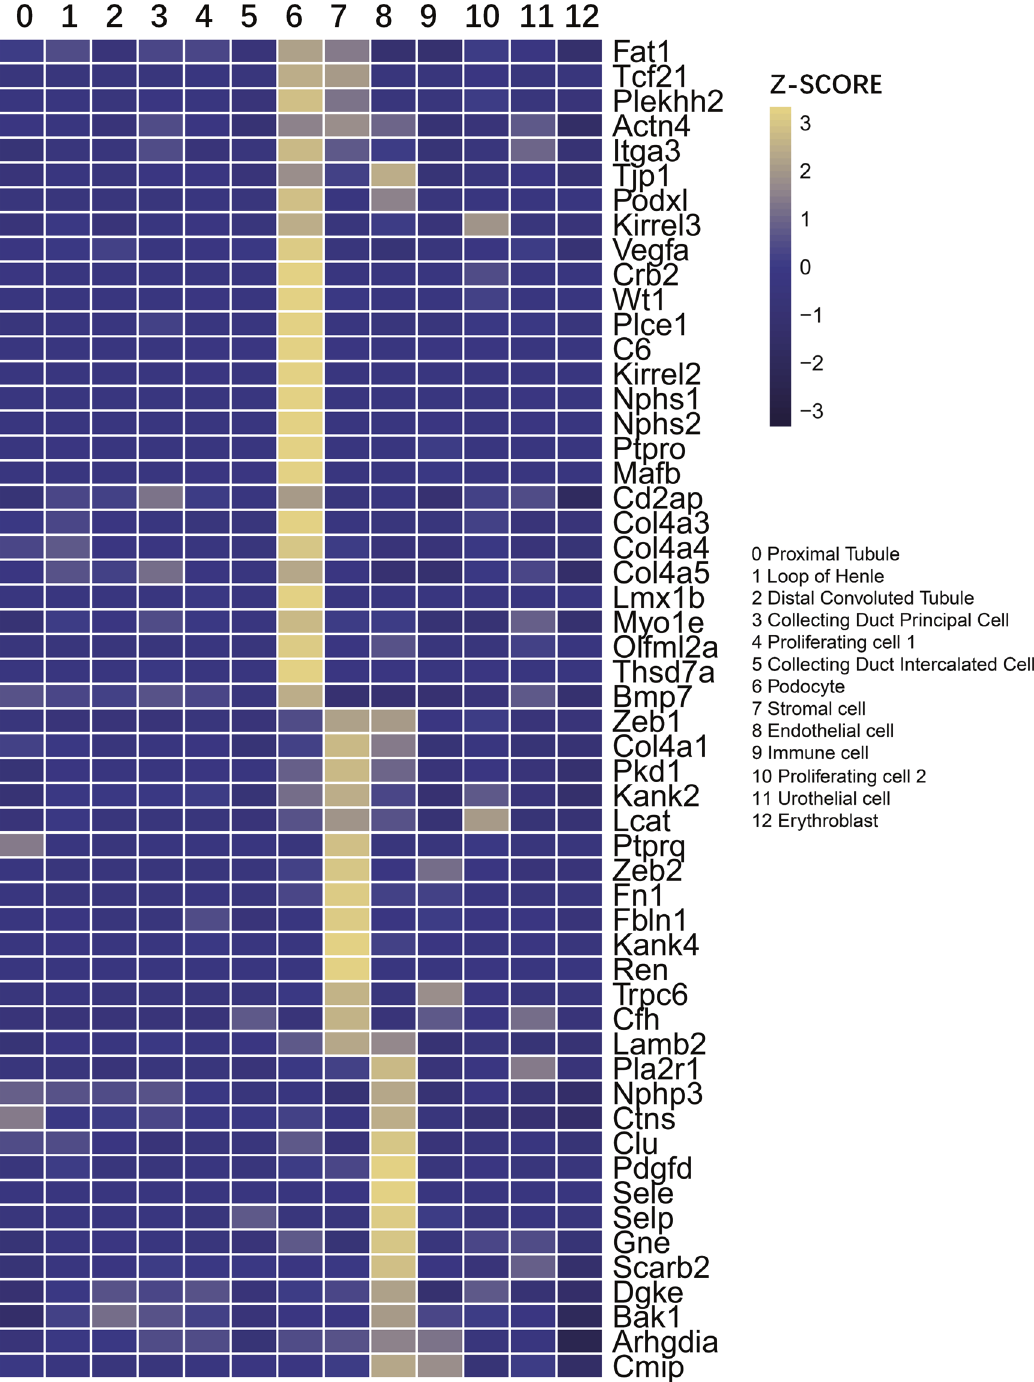
Fig. 5 Expression features of known glomerular diseases genes. Clustered expression of known glomerular disease genes collected from OMIM databases and genes showing high expression in podocytes, endothelial cells, and stroma cells are listed. Color keys indicate relative expression level and based on the z -score distribution. In the heatmap, each row represents one gene and each column is a single cell type. The full list of known glomerular disease genes and cell type is shown in Fig. Single cell isolation experimental protocols conformed to the Institutional Animal Care For each sample, intact kidneys (from rats at postnatal days 0, 2, 5, 10, and Guidelines. Pregnant Sprague-Dawley rats were purchased from Charles River Laboratories (Beijing, China). At each time point, three rats (pups) at each time point were anesthetized by CO 2 inhalation, and then their kidneys were pooled as one sequencing sample. The sex of the pups was not determined before weaning (P0, P2, P5, P10, and P20). P56 male rats were used as a mature kidney control.